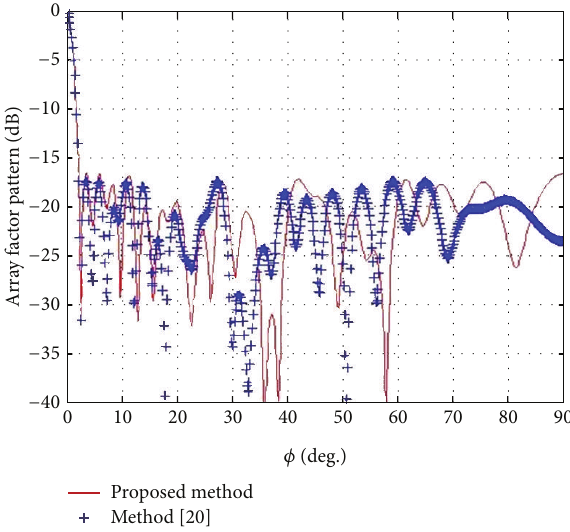
Figure 8: The comparison of array factor